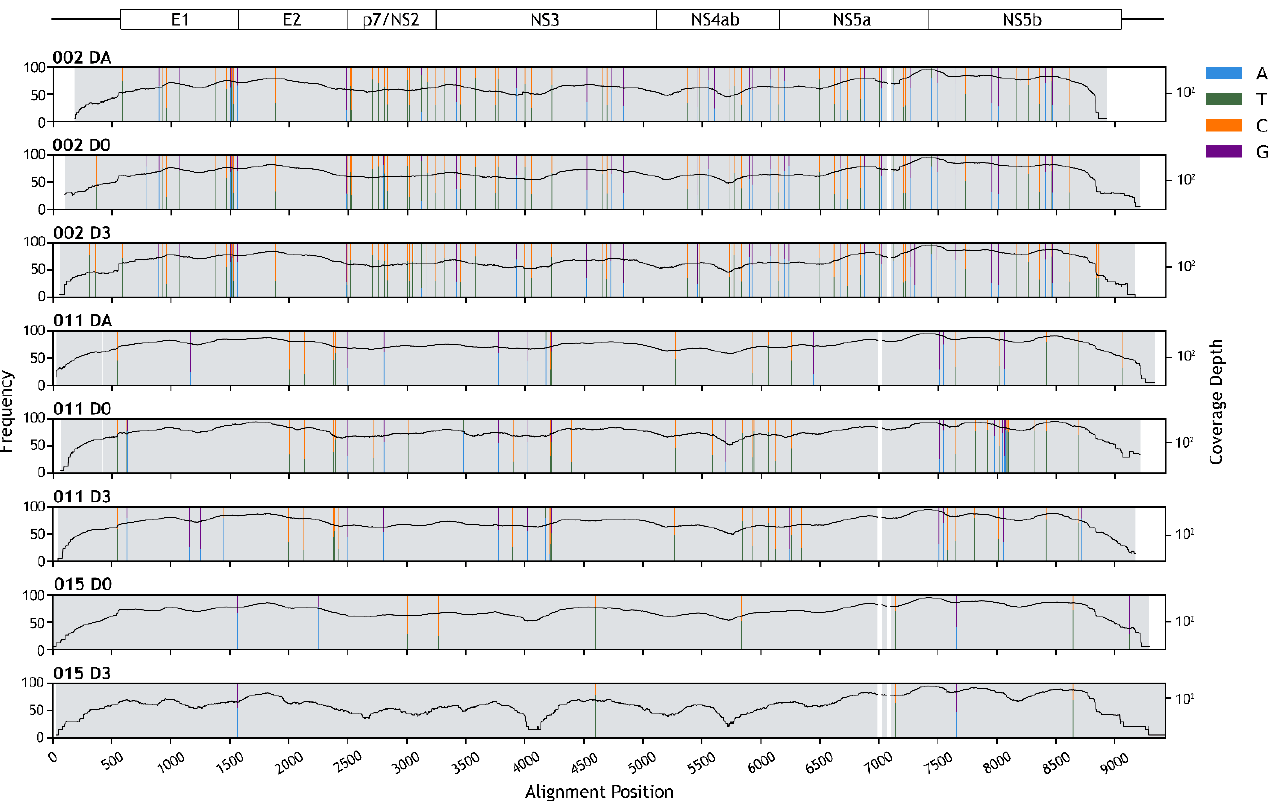
Figure 2. Human pegivirus-1 (HPgV-1) genome assembly. Schematic diagram of HPgV-1 genome organization is depicted at the top. Horizontal lines show untranslated regions, and rectangles show protein-coding regions. Positions of polymorphic sites are indicated by colored vertical stripes (see key for nucleotide variations). The height of the strips is proportional to the nucleotide frequency (left axis, linear scale). Black curves show the site-wise read depth of the genome assemblies (right axis, base-10 log scale). White regions indicate gaps in the sequence